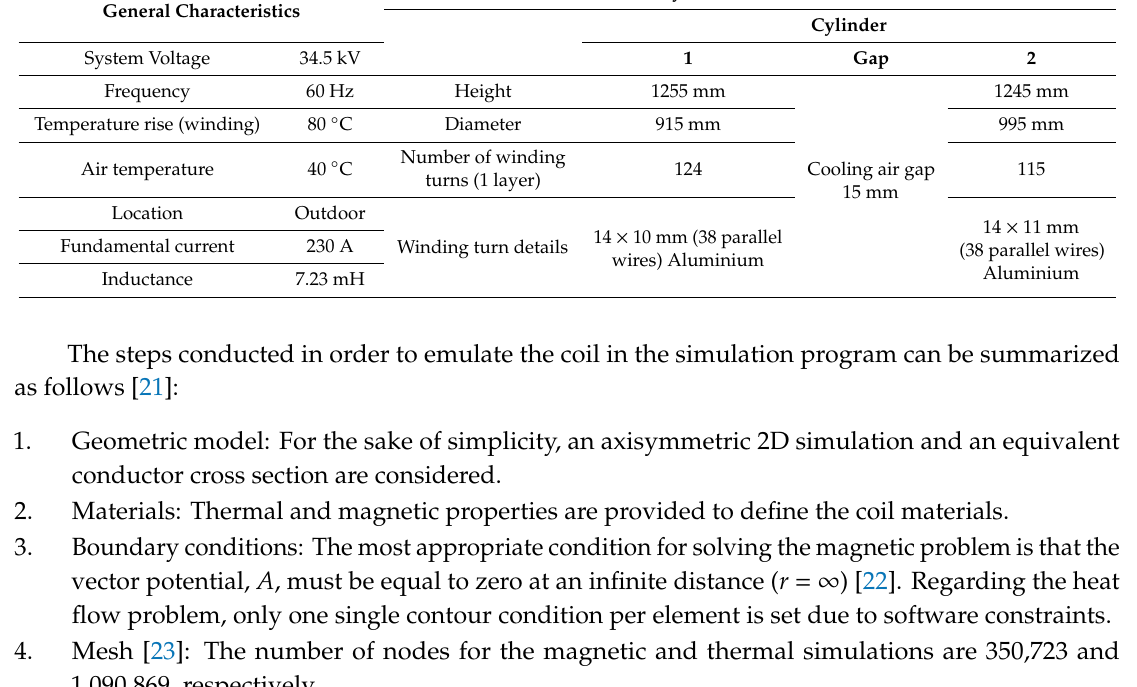
Figure 9. Trip curve used in the model.